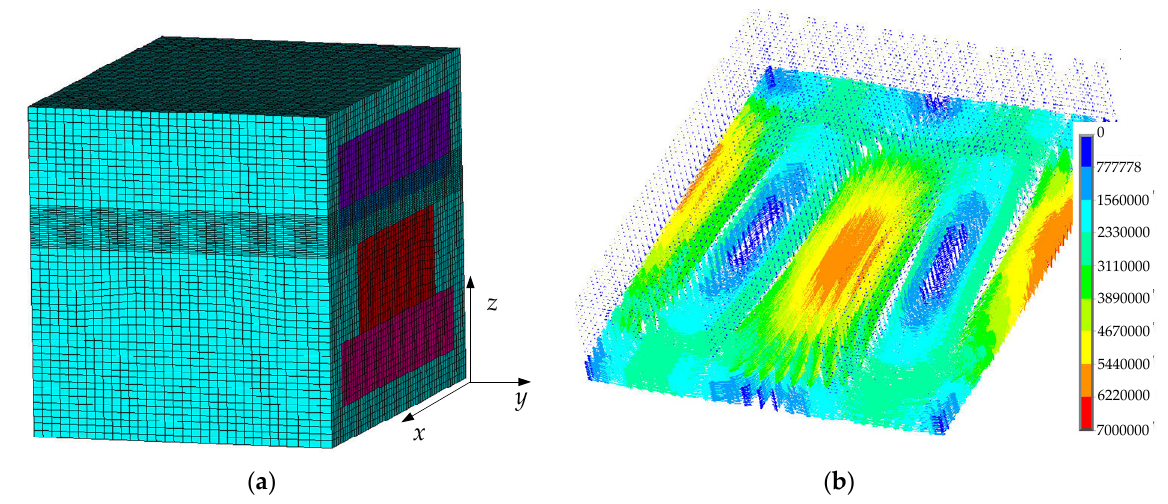
Figure 5. FEM meshes of the solved model ( a ) and eddy-current distribution of the model ( b ). The material’s nonlinear properties were considered in the finite element analysis to demonstrate the analytical model’s effectiveness and limitations. Since the relative velocity exists in the x-direction, a periodic boundary is used along the direction of motion. Figure 5b shows the eddy-current distribution of the ECC in region IV for a slip speed of 300 rpm. Figure 6 compares the analytically predicted flux densities and the FEM results of the model shown in Figure 3a in the region IV at z = R c + 1/1000, region III at z = R m + 3/1000, region II at z = R m − 1/1000, and region I at z = R r − 1/1000, respectively. The red line and symbol represent flux densities Br when the slip speed of the ECC is 300 rpm, and the blue line and symbol represent flux densities Bs when the ECC is static.